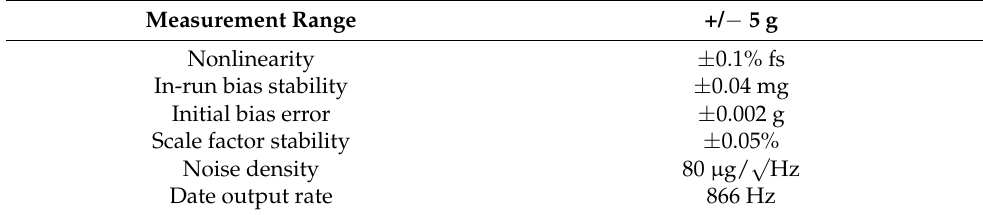
Table 2. Acceleration sensor type 3DM-GX3-25 specifications.